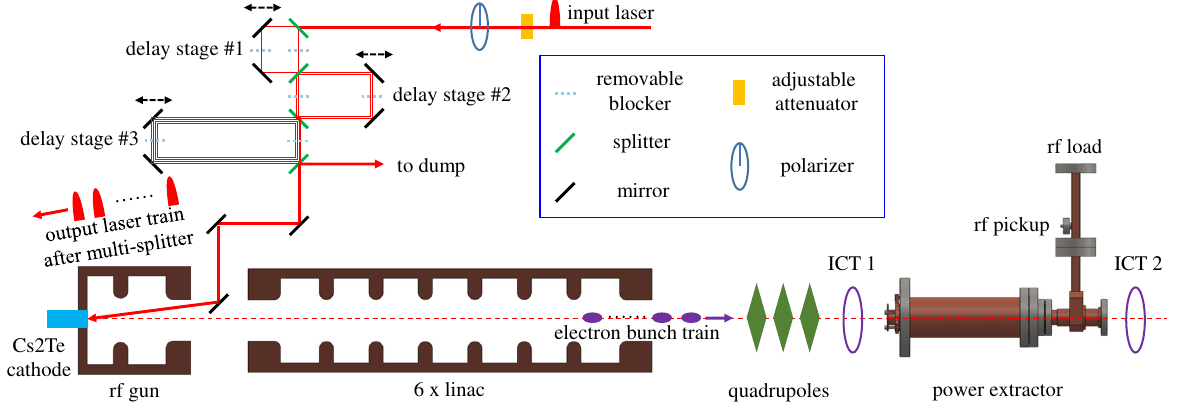
FIG. 13. Schematic of the high-power experiment at